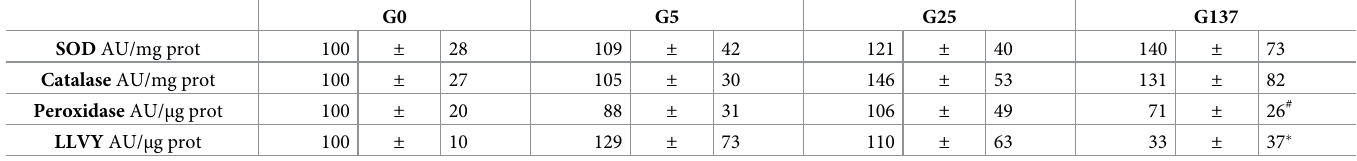
Table 3. Effect of glycation on erythrocyte enzymatic activites involved in redox balance and in oxidised protein degradation. Catalase, superoxide dismutase, perox- idase and chymotrypsine-like activity of the proteasome (LLVY). Enzymatic activities were determined as described in the material and methods section. G0, G5, G25 and G137 represent the four conditions of incubation to which erythrocytes were subjected: 0, 5, 25 and 137 mmol/l glucose, respectively. Results are expressed as mean ± SD (n = 4 to 9) and statistical analyses were performed using Tukey’s post hoc analysis following a significant one way ANOVA: � effect of erythrocyte glycation (vs. G 5): � p < 0.05. #p < 0.05 (vs.